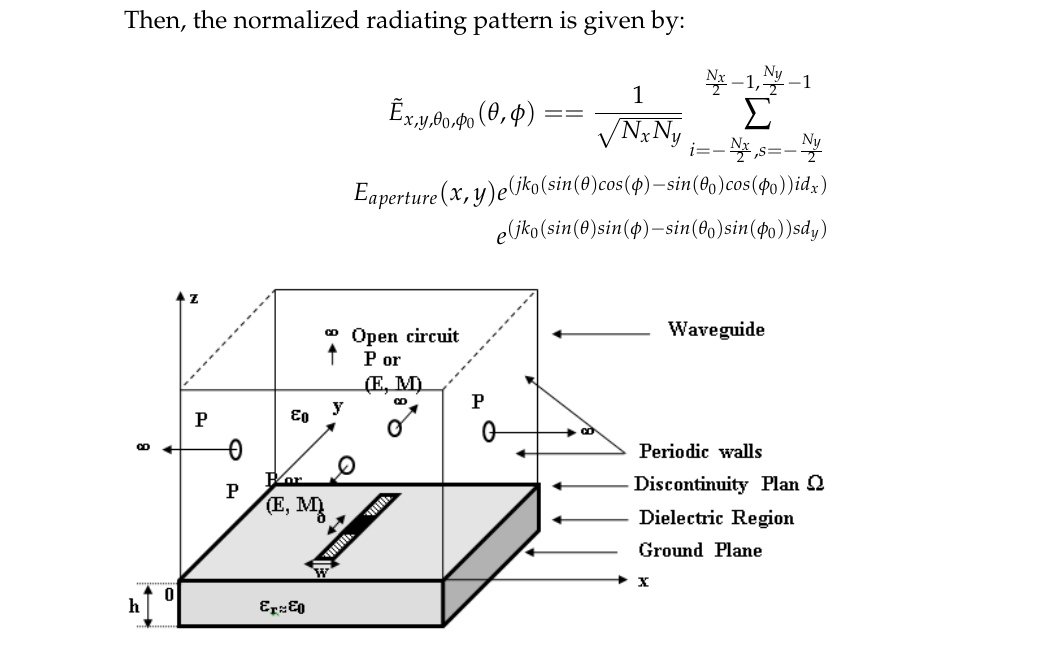
Figure 2. Section of periodic phased array microstrip lines (planar dipoles): unit cell delimited by periodic